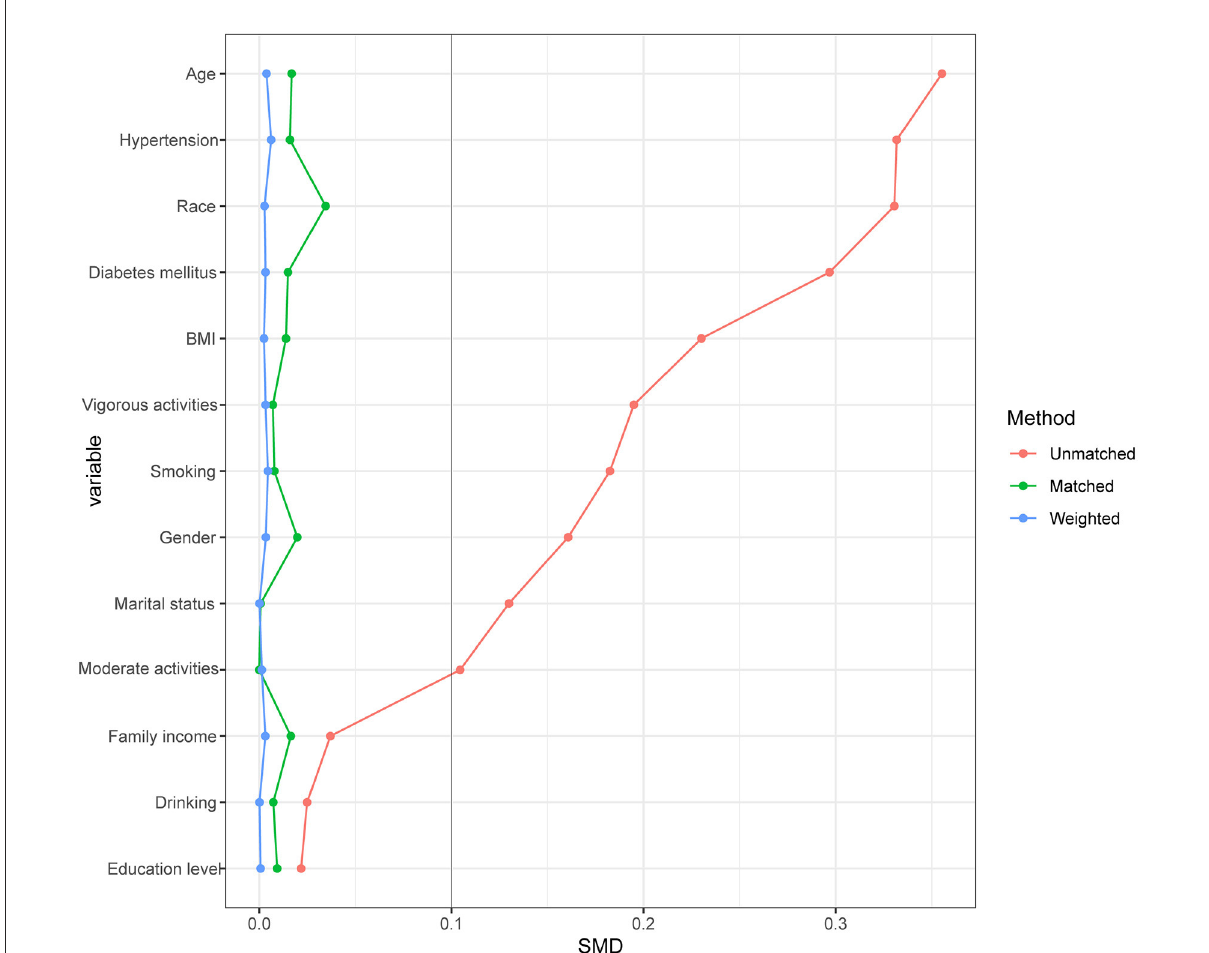
FIGURE3 Propensity score matching analysis of the standardized mean difference results for the different